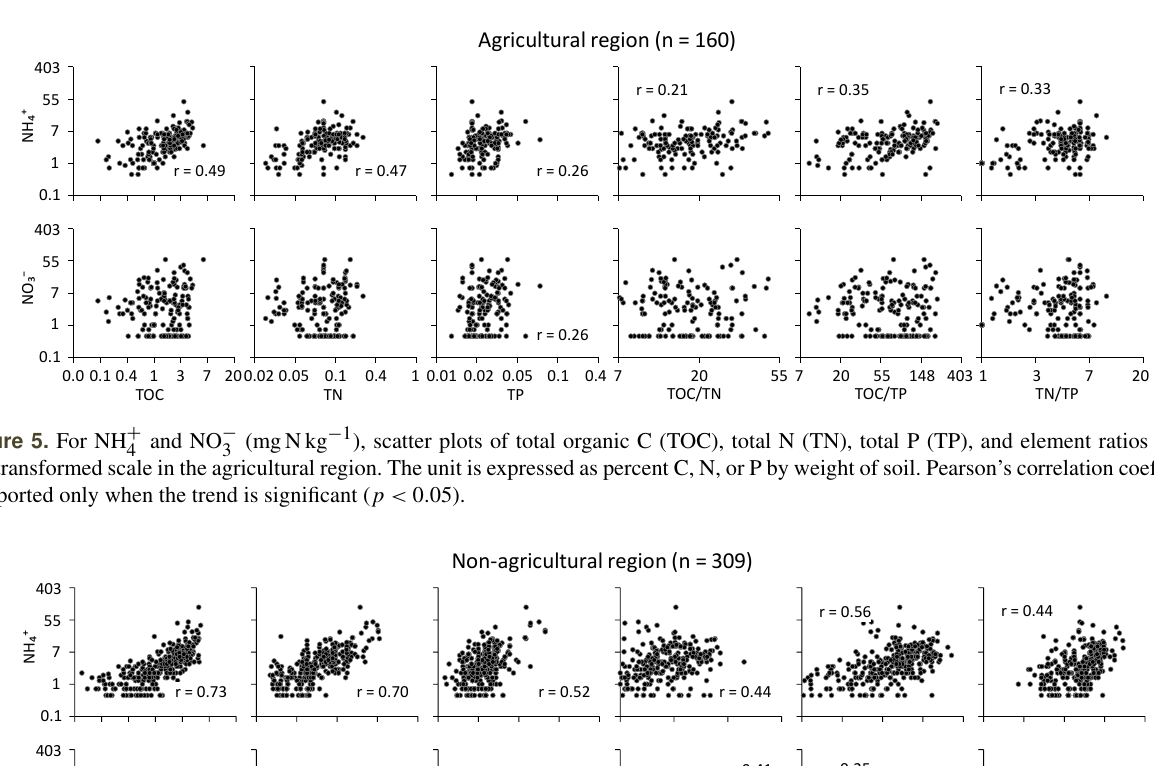
and NO − contents 4 3